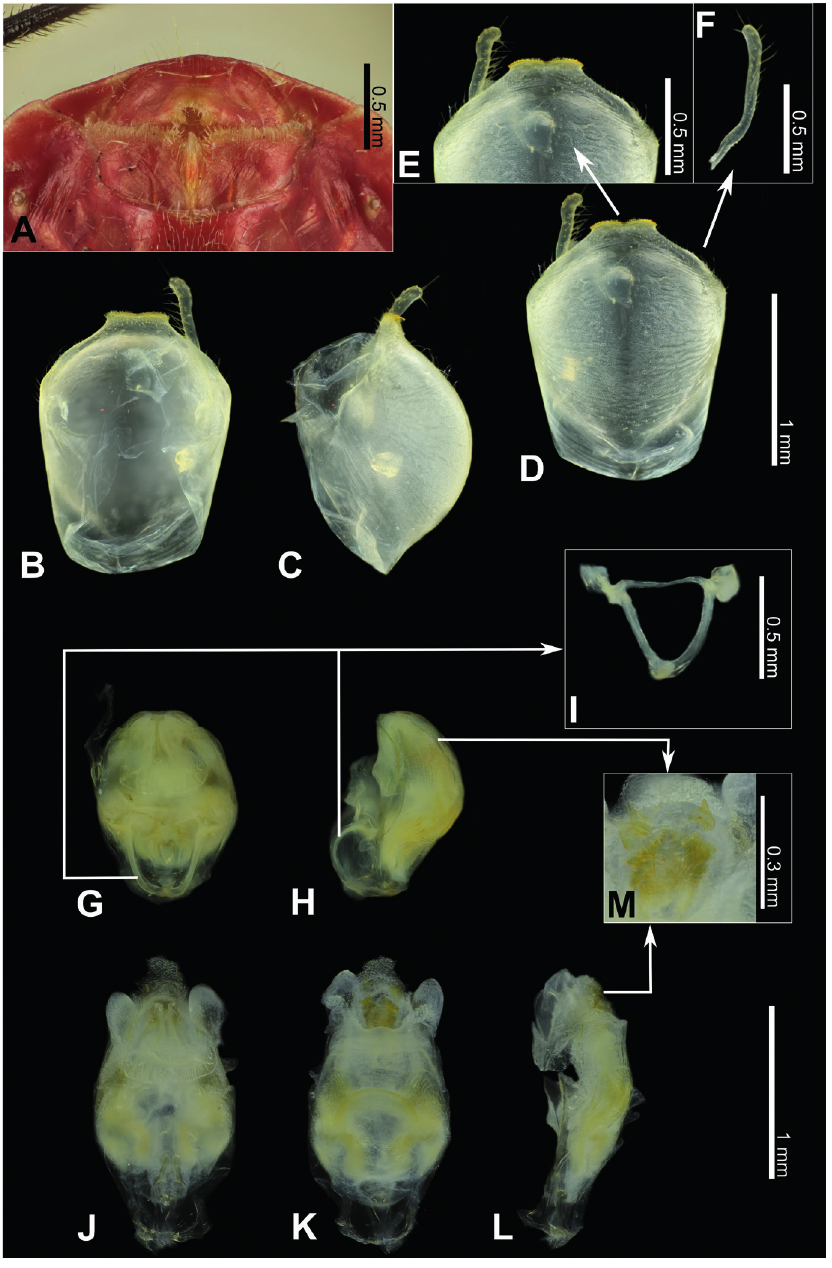
Figure 18. Biasticus griseocapillus Ha, Truong & Ishikawa, sp. nov. A female genitalia in ventral view, holotype, ♀ , HNL2018-038 B–M male genitalia, paratype, ♂ , TXL2016-546 B–F pygophore with para- mere B dorsal view C lateral view D ventral view E apical portion of pygophore, showing median process (mpp) and paramere F left paramere G–M phallus G dorsal view H lateral view I articulatory apparatus (aa) J aedeagus with endosoma semi-everted, dorsal view K aedeagus with endosoma semi-everted, ventral view L aedeagus with endosoma semi-everted, lateral view M distal dorsal lobe of endosoma